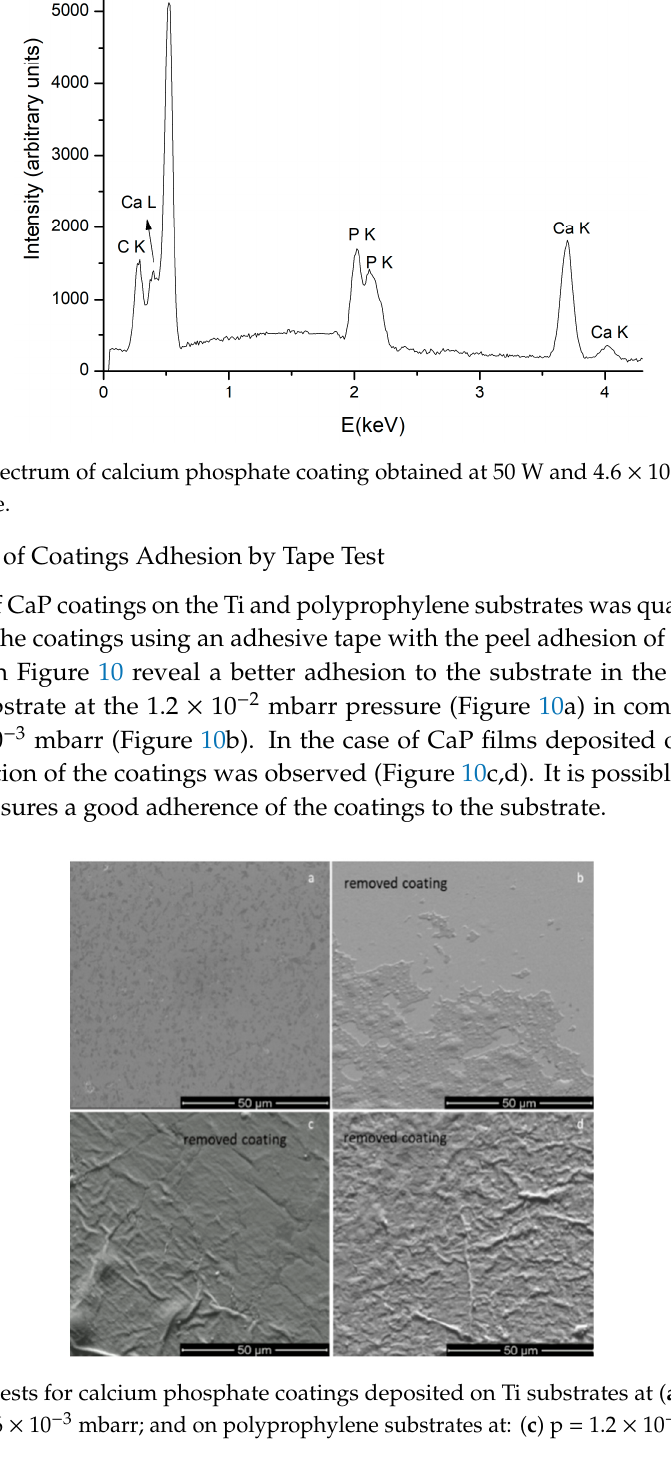
11 of 16 Figure 8. SEM image of: ( a ) polymer substrate; ( b ) calcium phosphate coating generated in a continuously single run in magnetron sputtering discharge for 2 h with no pauses. An elemental analysis of the coatings deposited on Ti and polyprophylene substrates has been performed by electron dispersive spectroscopy (EDS). The EDS spectrum of a CaP layer is presented in Figure 9. It ascertains the presence of Ca, O, P elements in the layer for both Ar gas working pressures. The Ca/P atomic ratio was determined from